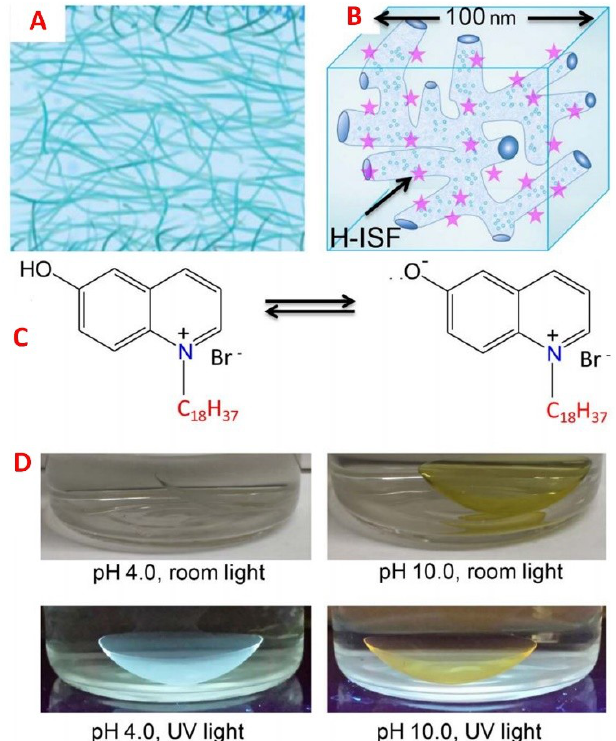
Figure 5. ( A ) Schematic of the non‐silicone hydrogel contact lens showing cross‐linked polymer strands that are spatially homogenous as compared to ( B ) the silicone hydrogel lenses with hydrophilic and hydrophobic regions that facilitate the binding of hydrophobic ion‐sensitive fluorophores. ( C ) The neutral and anionic equilibrium of pH probe, 6HQ‐C18. ( D ) Images of a contact lens labelled with 6HQ‐C18 at pH 4.0 and 10.0 under ambient or UV light. Reprinted and adapted with permission [88]. Copyright 2018, Elsevier.